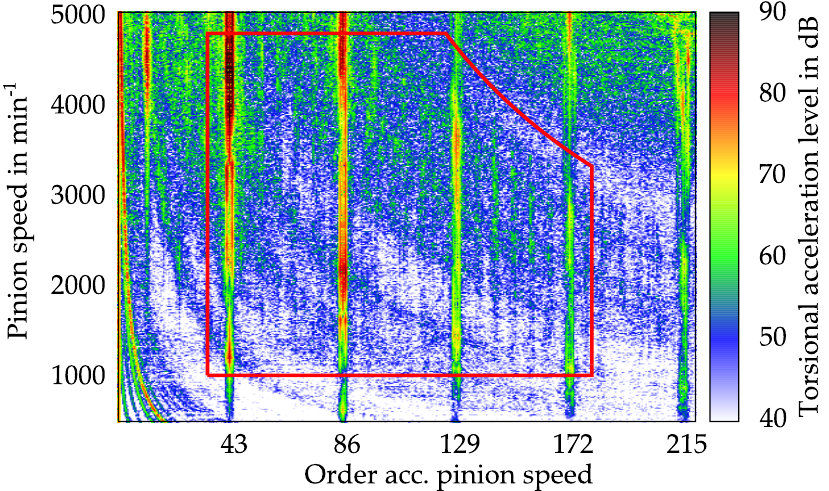
Figure 8. Exemplary Campbell-diagram with leveled amplitudes, that shows the torsional accelera- tion measurement of polish ground gears at 800Nm. The relevant operating range for the application force level is marked with red